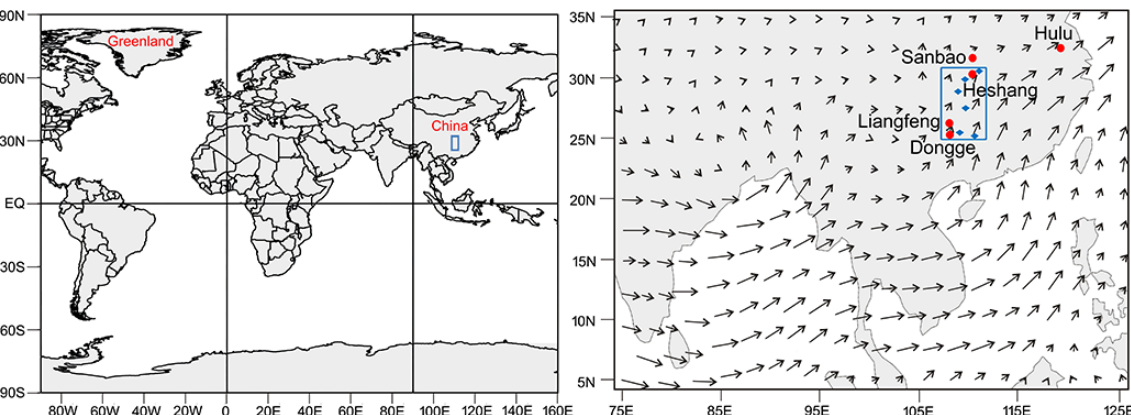
Figure 1. Location maps. The left map shows the location of Greenland and southwest China (blue box). The right map shows the location of Heshang cave and other Chinese caves (red points), with the main feature of the summer monsoon marked. Smaller arrows reflect mois- ture transport and direction averaged over the whole atmosphere (Ding et al., 2004). The blue box indicates the specific region for which comparison of Heshang and Dongge allows rainfall reconstruction, and the blue diamond patterns show the location of six modern rainfall stations detailed in Hu et al.